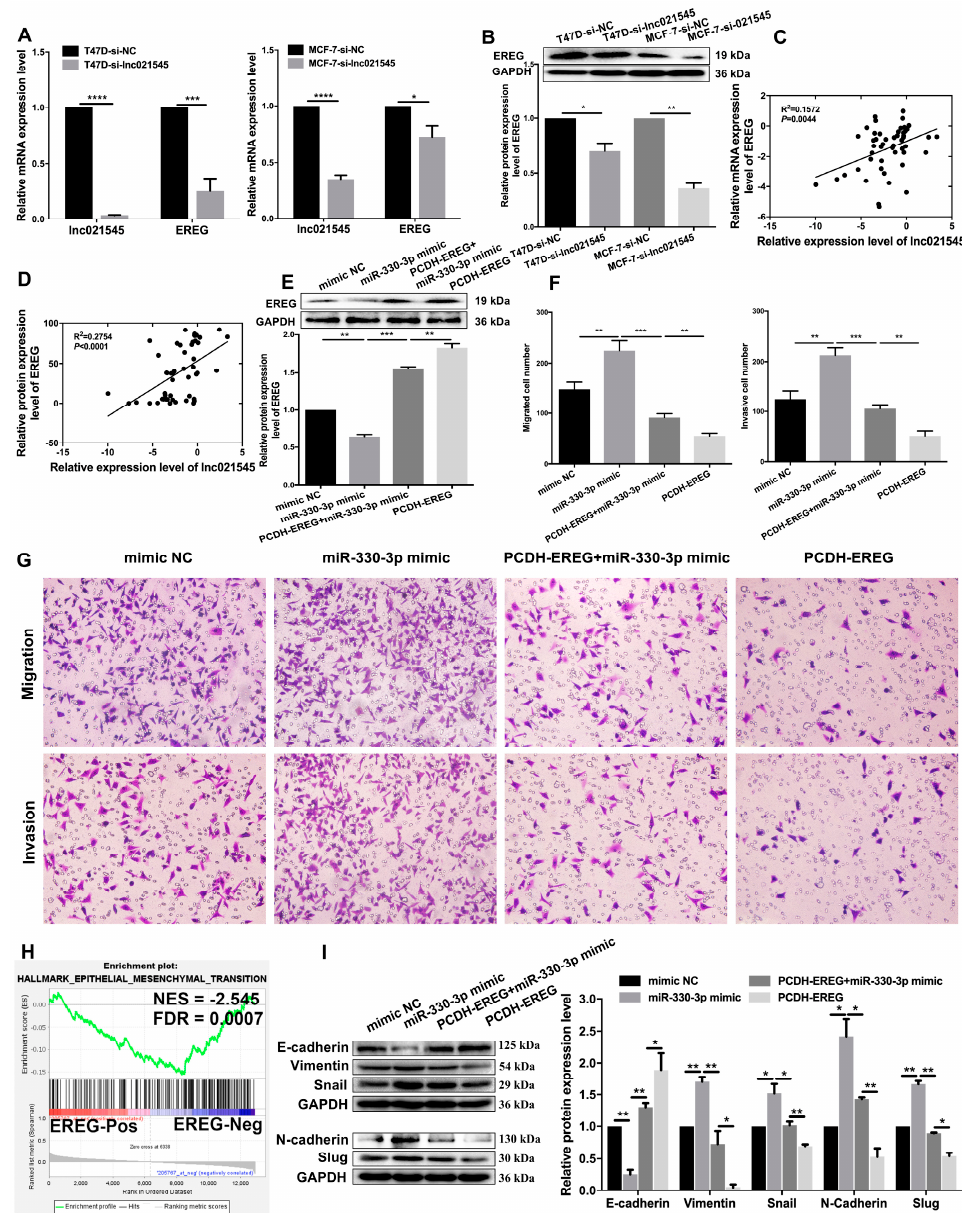
Figure 7. Lnc021545/miR-330-3p regulates BC metastasis by affecting the expression of EREG. Effects of knockdown lnc021545 on EREG mRNA ( A ) and EREG protein ( B ) in T47D and MCF-7 cells. Correlation between lnc021545 and EREG mRNA ( C ) and EREG protein ( D ) in 50 BC tissues. In the rescue experiment, EREG protein expression level was detected using a WB assay ( E ); migration and invasion of MCF-7 cell line were measured using a transwell assay ( F , G ). Single-gene GSEA showing the association between EREG and EMT based on GSE3494 dataset ( H ). The expression levels of EMT markers were measured using WB assays in the rescue experiment ( I ) (* p < 0.05, ** p < 0.01, *** p < 0.001, **** p < 0.0001, n =